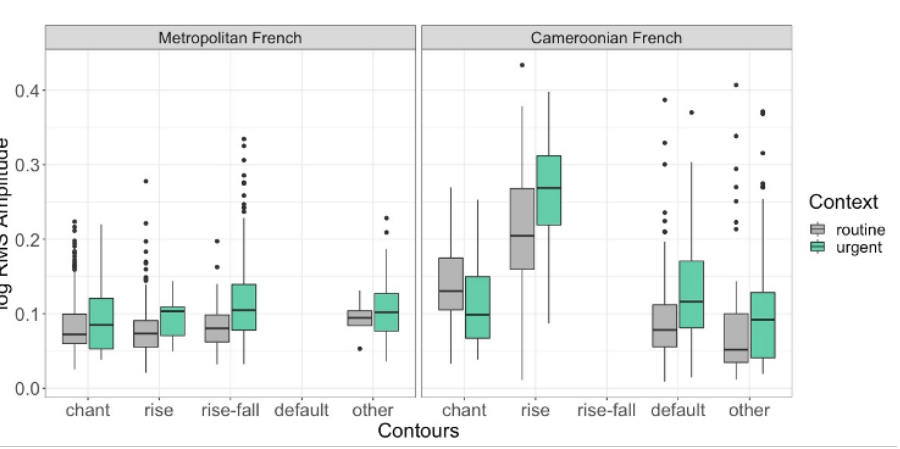
Figure 18. RMS amplitude in the routine and urgent context across different calling melodies in MF and